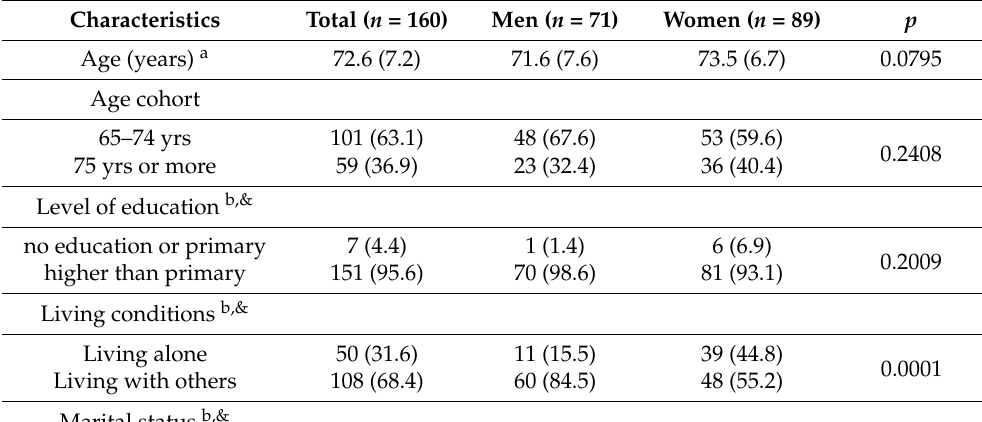
Table 3. Characteristics of the whole study population and according to